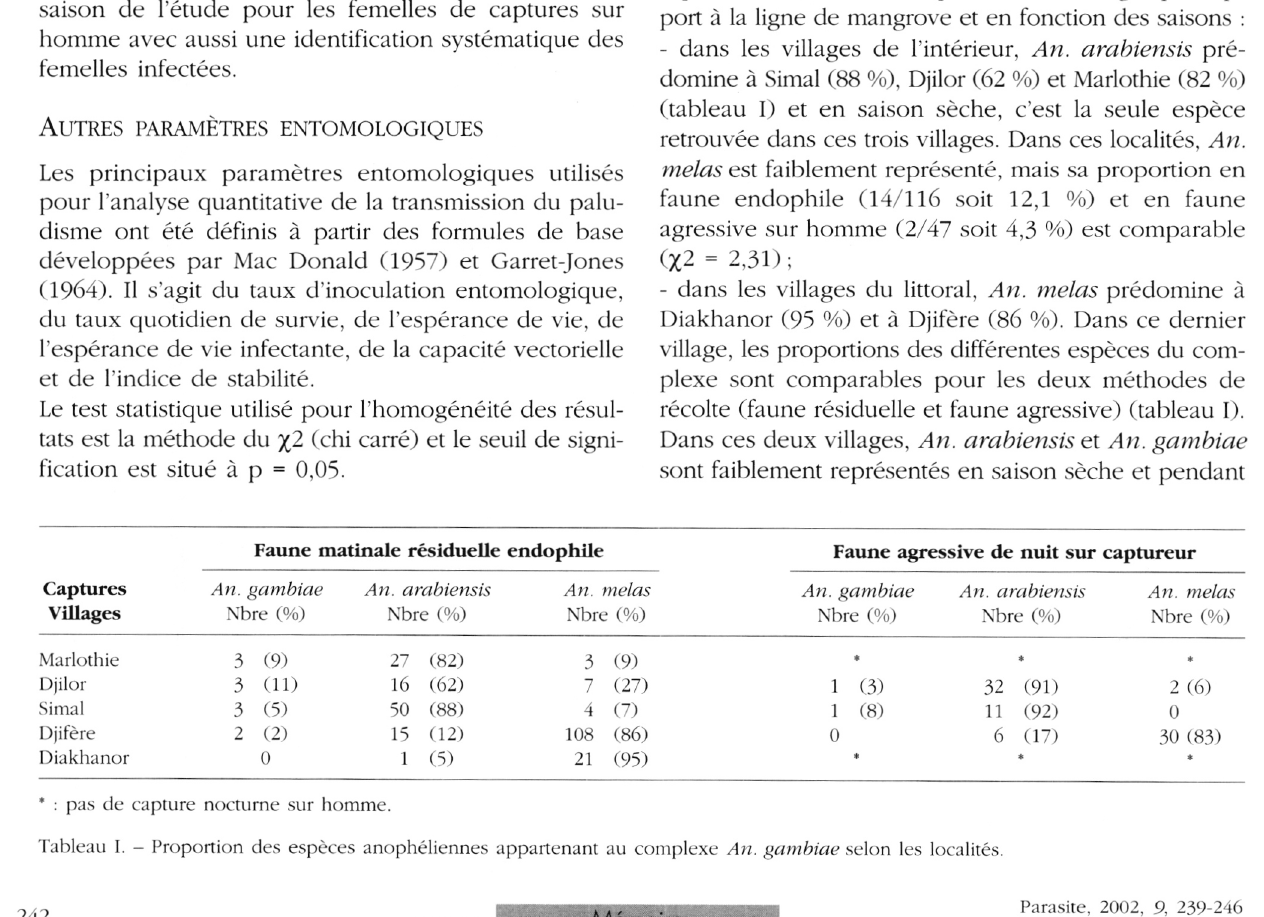
242 Mémoire Parasite, 2002, 9,